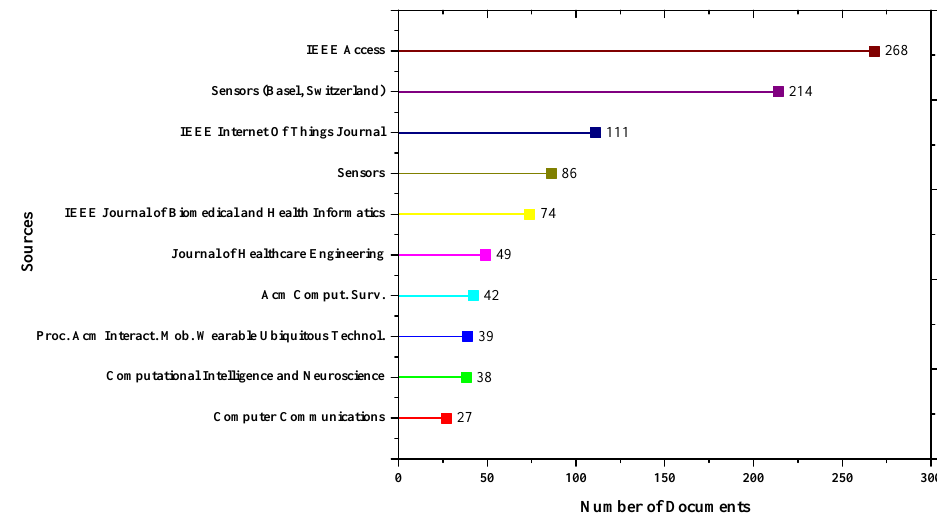
Figure 3. The Top 10 Most Relevant Sources publishing IoMT